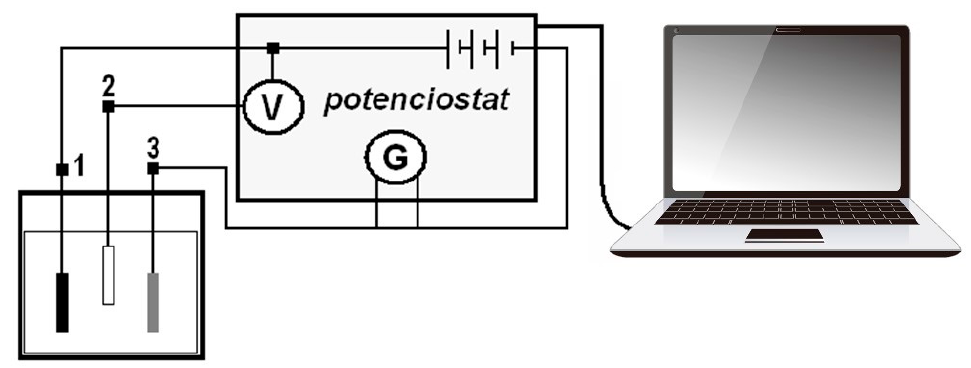
Figure 1. Wiring scheme of a device for measuring linear polarization (1—sample; 2—reference electrode; 3—auxiliary electrode).